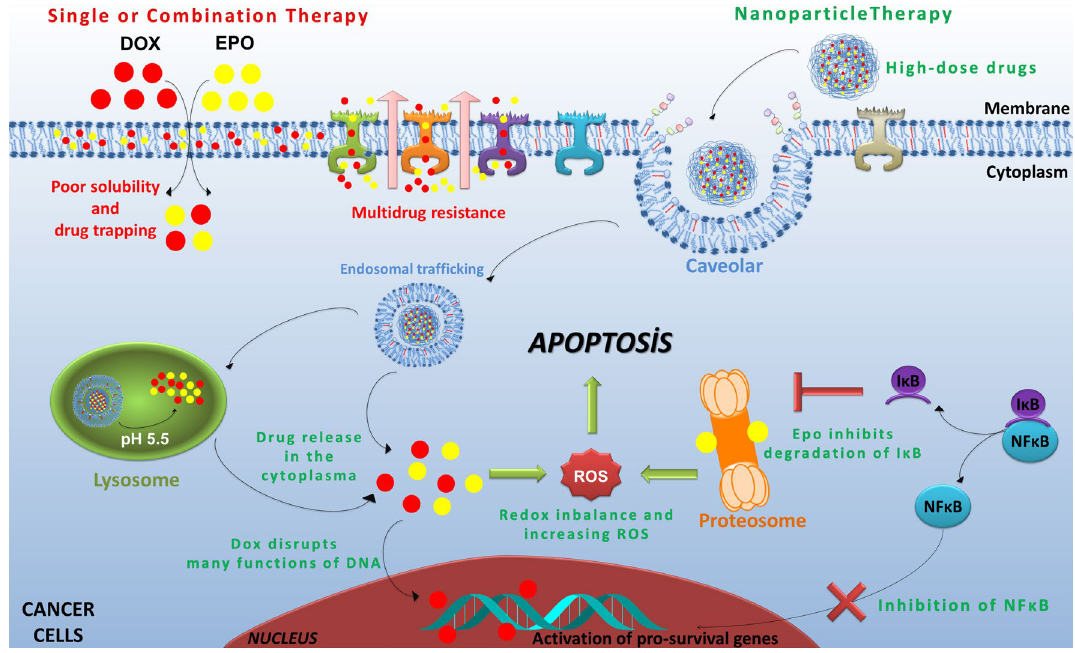
Figure 9. The advantages of nanoparticle therapy to single or combined application in free state are summarized in figure. Dox + Epo-NPs overcame drug resistance by suppressing NF-κB activation, proteasome inhibition, inducing apoptosis in breast cancer cells, and without exerting these effects in normal